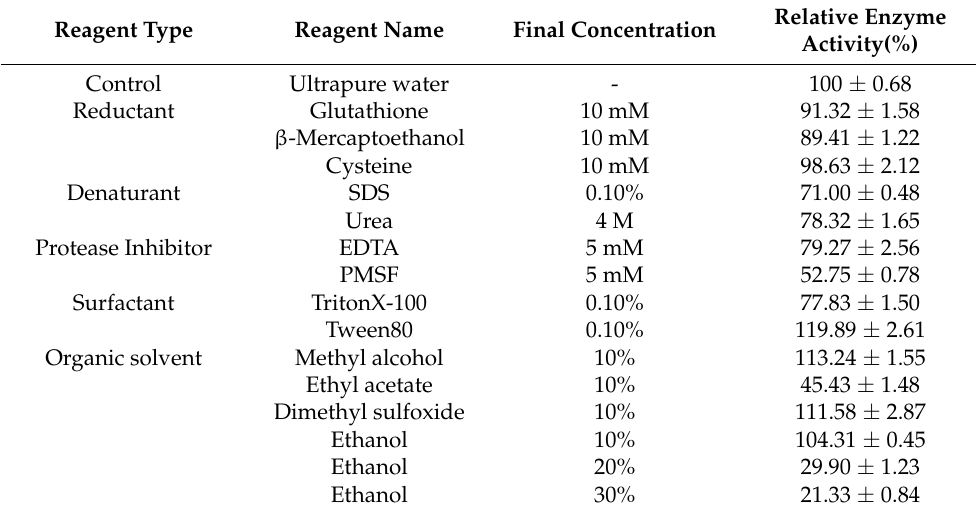
Table 3. Effects of several chemical reagents on protease